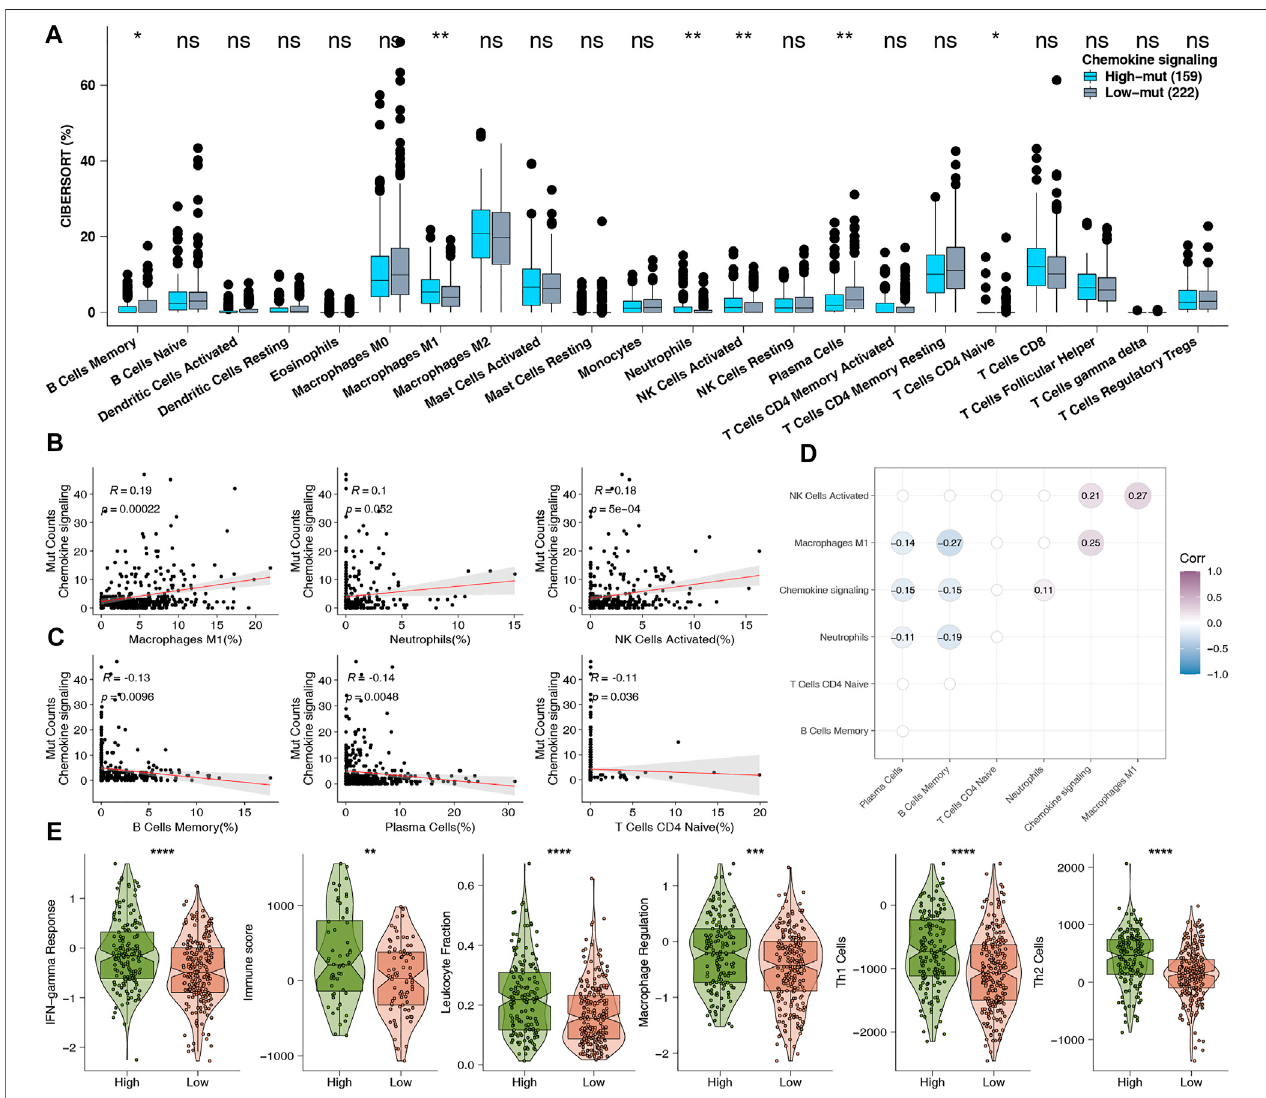
FIGURE 5 | (A) Comparison of the proportions of 22 types of immune cells estimated by the CIBERSORT method between high-mut and low-mut tumors in the TCGA-COADcohort. (B) Thecorrelationbetweentheproportionofeachhigherdegreeofin fi ltrationimmunecellsandthecountsofDDRpathway mutationsinthehigh- mut group of TCGA-COAD cohort. (C) The correlation between the proportion of each lower degree of in fi ltration immune cells and the counts of DDR pathway mutations in the high-mut group of TCGA-COAD cohort. (D) The difference in proportion of 22 types of immune cells. (E) Comparison of immune related scores betweenhigh-mutandlow-muttumorsintheTCGA-COADcohort.TheimmunerelatedscoreswereIFN-gammaResponse,Immune,LeukocyteFraction,Macrophage Regulation, Th1 Cell, and Th2 Cell scores.